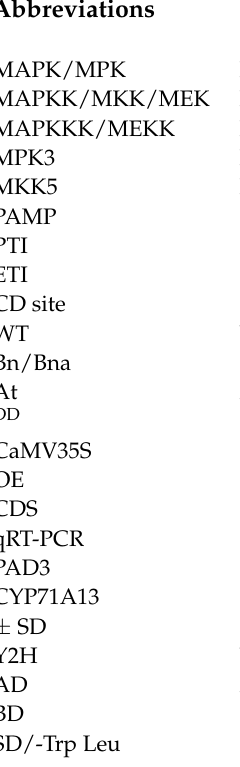
MPK4/5 copies in Brassica napus and Arabidopsis . Figure S2: Phylogenetic analysis showing the relationship between each copy of B. napus MKK5 and MKK4/5 in Brassica species, as well as MKK4/5 in Arabidopsis . Figure S3: Sequence alignment of B. napus MPK3/6 copies. Table S1: Lesion areas of infected oilseed rape leaves after 48 h incubation with S. Sclerotiorum . Table S2: Primers used in this